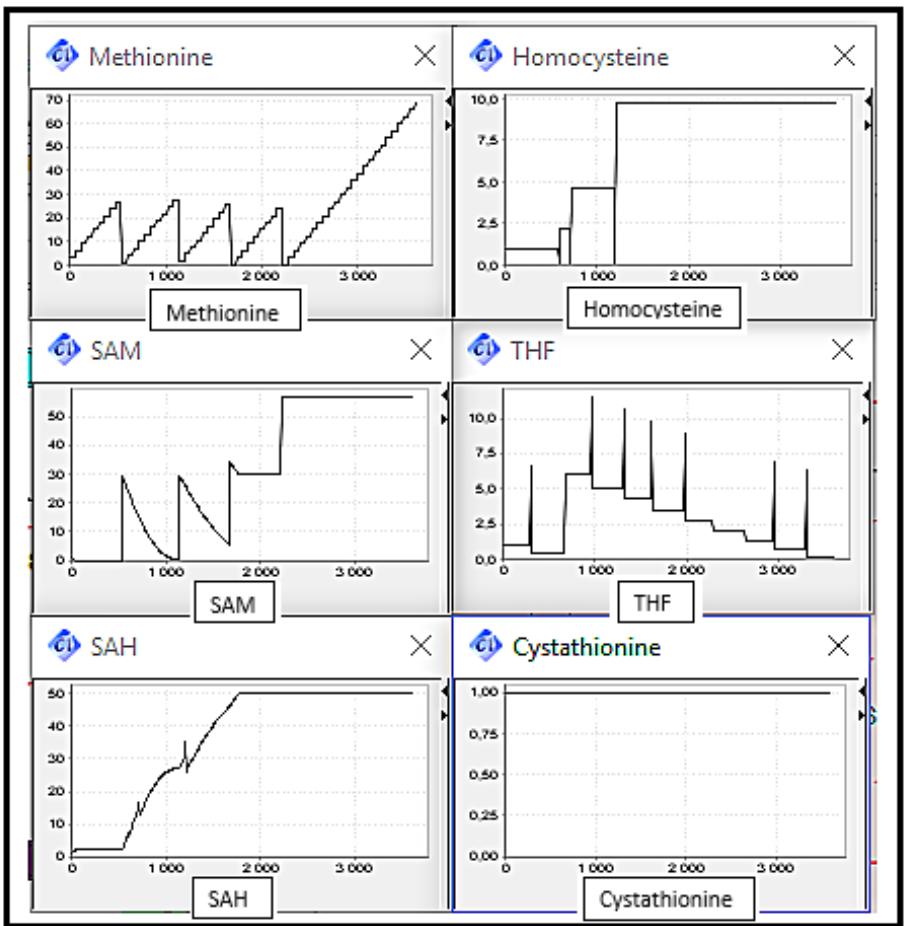
Figure 9. Simulation of the HFPN model representing the studied metabolic pathway in case of MS, BHSM and CBS Deficiencies (Scenario